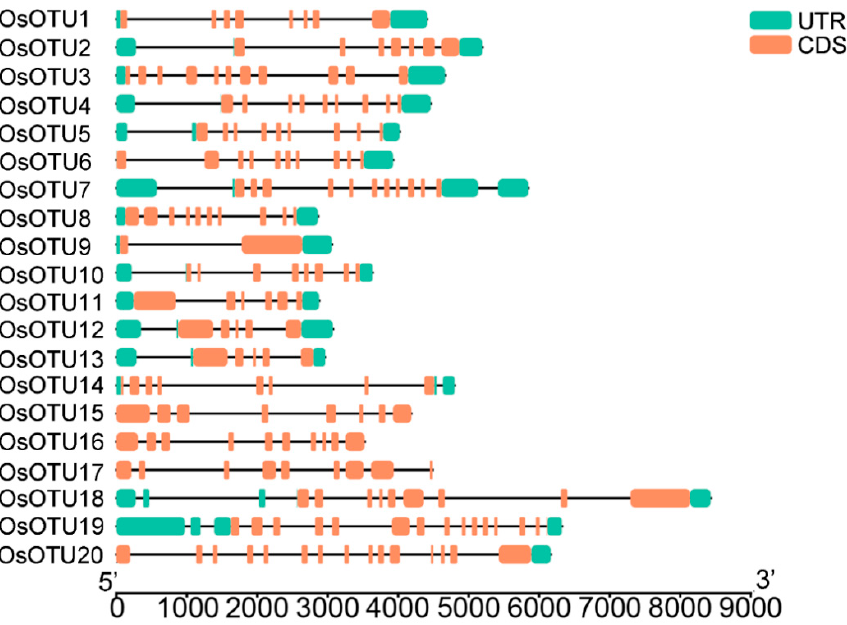
Figure 3. Exon–intron structure analysis of OsOTU family proteins. Green rectangles indicate untranslated regions (UTRs) from 5 ′ and 3’, red rectangles indicate exons, and black lines indicate in- trons.